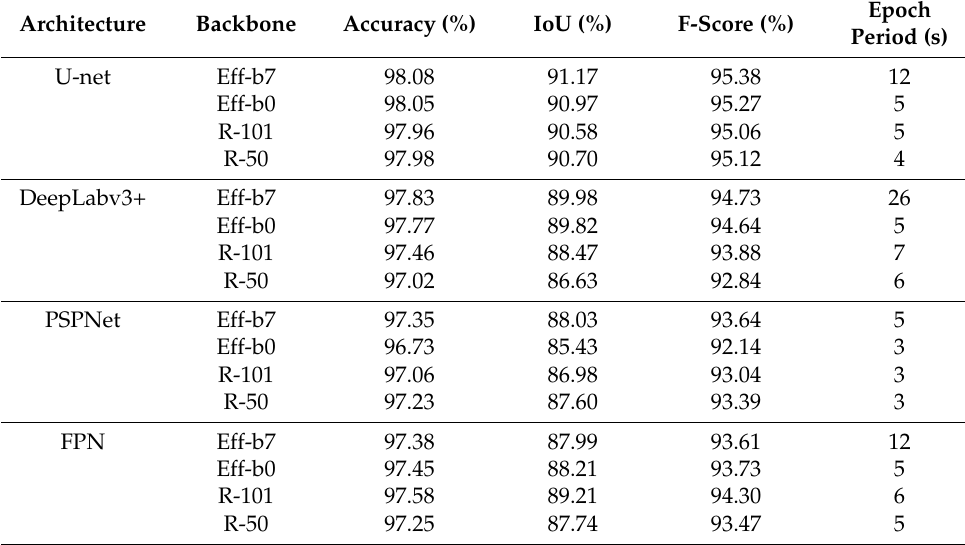
Table 3. Semantic segmentation evaluation (accuracy, IoU, F-score, and epoch period) using three ar- chitectures (U-net, DeepLabv3+, and PSPNet), and four backbones (Efficient-net-b7 (Eff-b7),